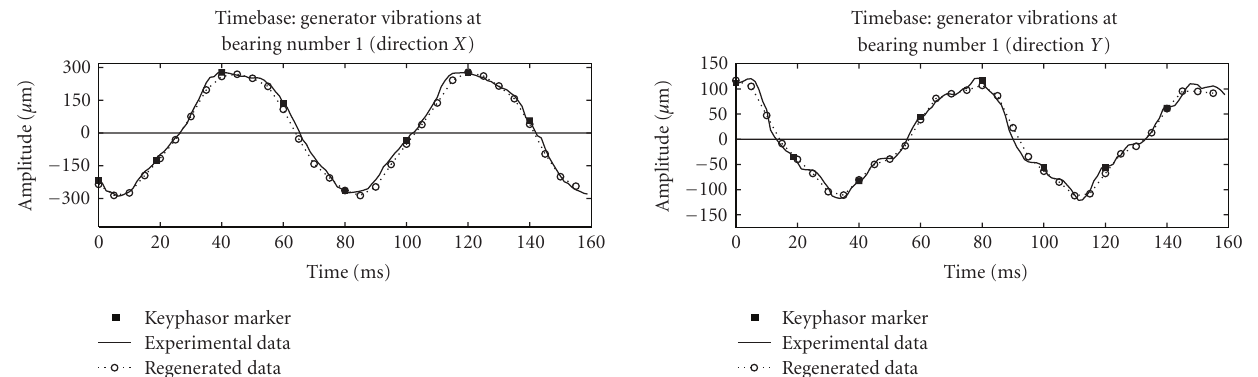
Figure 4: Comparison between the experimental vibration signal measured at bearing no. 1 in the X and Y directions, during an instability onset, and the respective regenerated signals obtained considering the harmonic orders 0.26X, 0.5X, 1X, and 2X reported in Table 1.